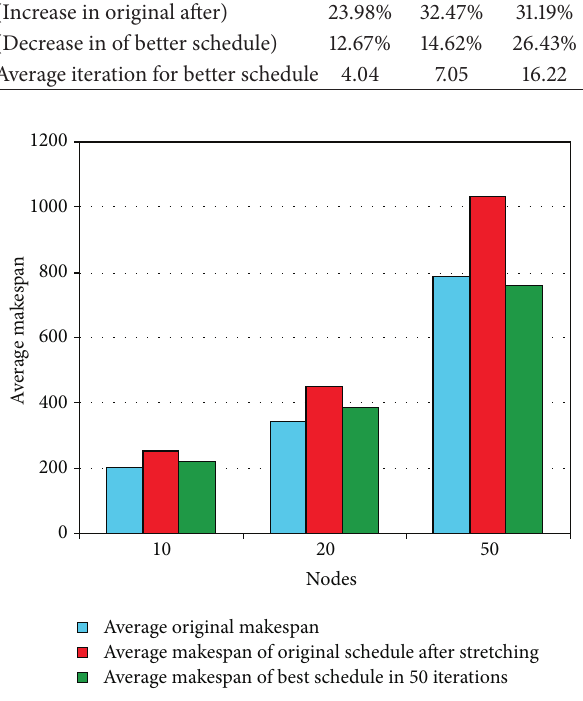
Figure 12: Results for DAGs with different number of